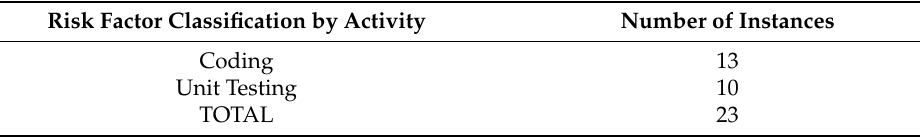
Table 3. The implementation and unit testing stage risk factors.